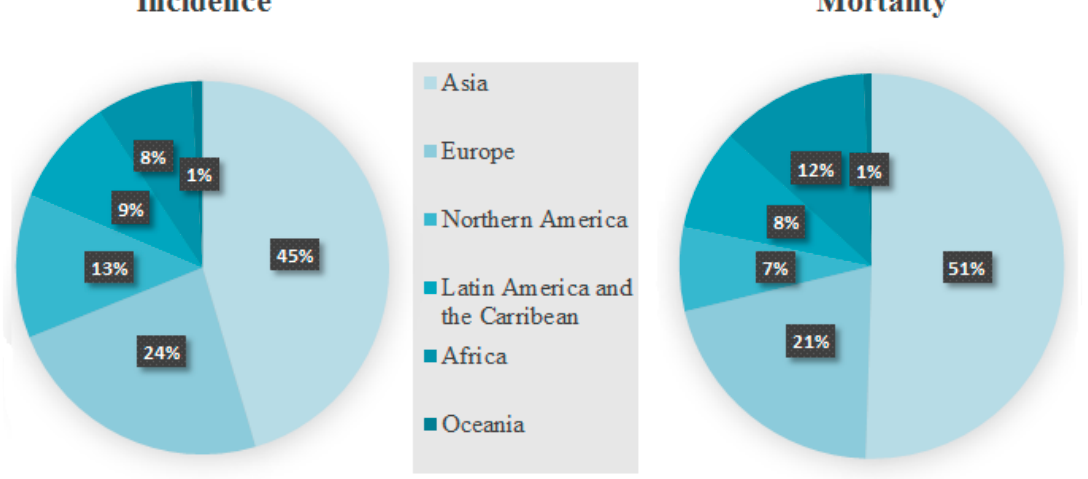
Figure 1. Breast cancer incidence and mortality in 2020 for women [1].